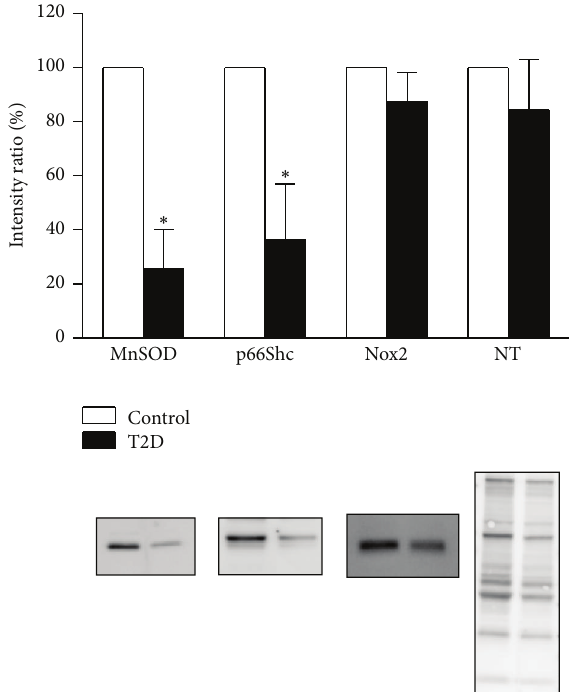
Figure 4: Arterial protein expression levels of MnSOD and p66Shc, but not Nox2 or 3-NT, were significantly decreased in T2D rats compared to control rats ( 𝑛 = 3 each; 𝑃 = 0.039 and 𝑃 = 0.028 , resp.; t -test). Representative immunoblots are shown below thesummarydata.Relativeproteinlevelswerecalculatedastheratio of the intensity of the chemiluminescent bands to the intensity of the total protein loaded on the gel and are expressed as a percentage of the values measured in control